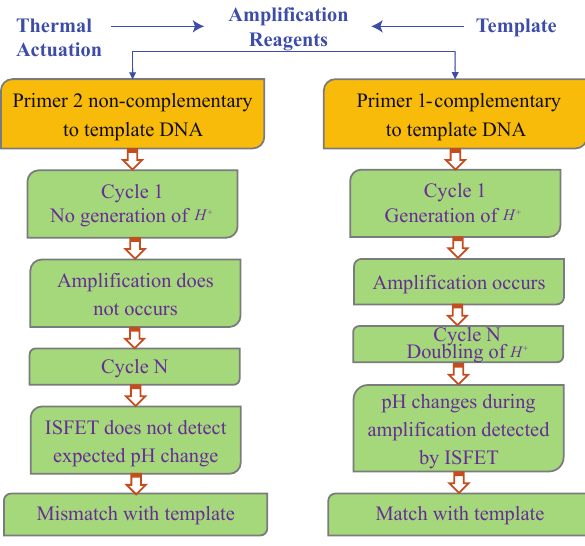
Figure 4. pH detection